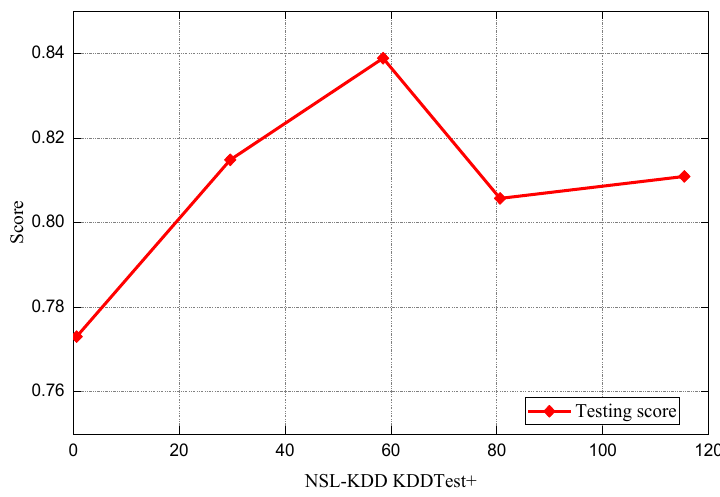
Figure 27. F1-score of the genetic algorithm with ( M = 60 ) .